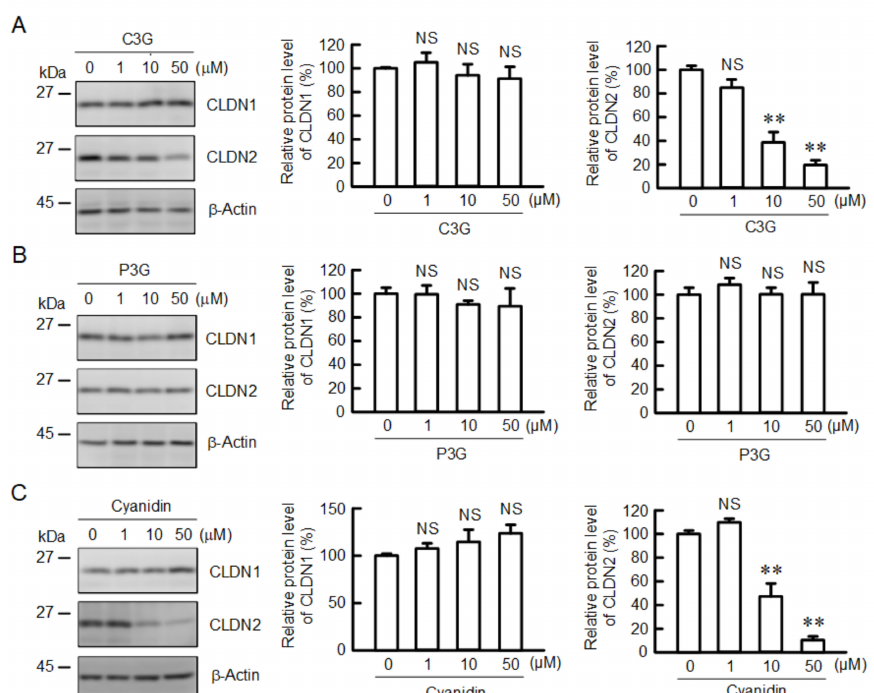
Figure 1. Effects of anthocyanins on the protein levels of CLDN1 and CLDN2 in A549 cells. Cells were incubated with 0, 1, 10, or 50 µ M C3G ( A ), P3G ( B ), or cyanidin ( C ) for 24 h. Cell lysates were immunoblotted with anti-CLDN1, anti-CLDN2, and anti- β -actin antibodies. The protein levels of CLDN1 and CLDN2 are represented as a percentage relative to 0 µ M.